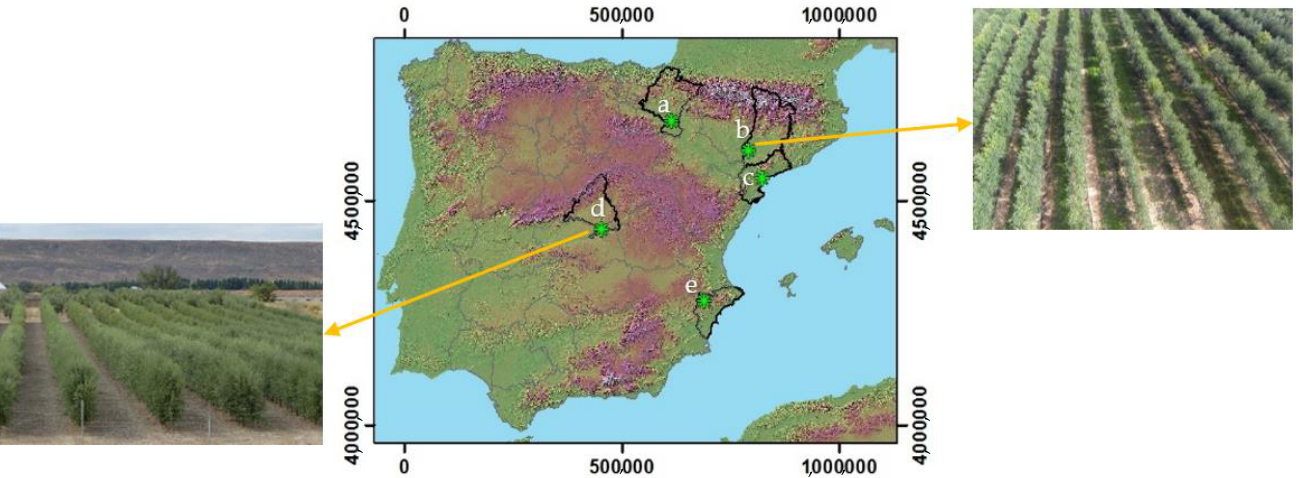
Figure 1. Plot location on Iberian Peninsula map: ( a ) Cadreita (Navarra); ( b ) Torres del Segre (Lleida); ( c ) Constantí (Tarragona); ( d ) Colmenar de Oreja (Madrid); and ( e ) Villena (Alicante). Two pictures of the Madrid and Lleida olive orchards are shown.